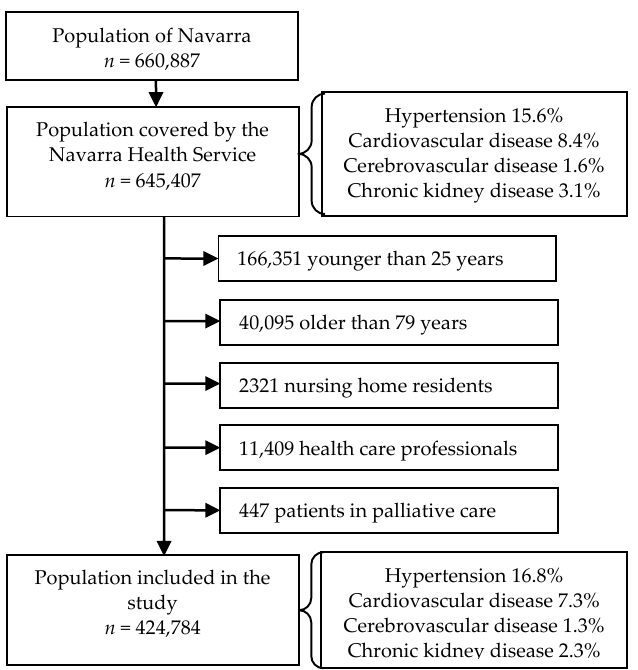
Figure 1. Flow chart of the cohort definition.